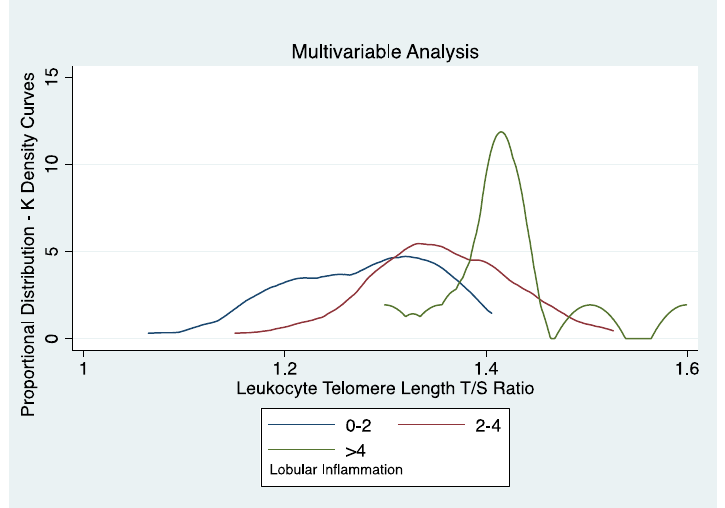
Figure 1. Leukocyte telomere length association with lobular inflammation multivariable analysis.